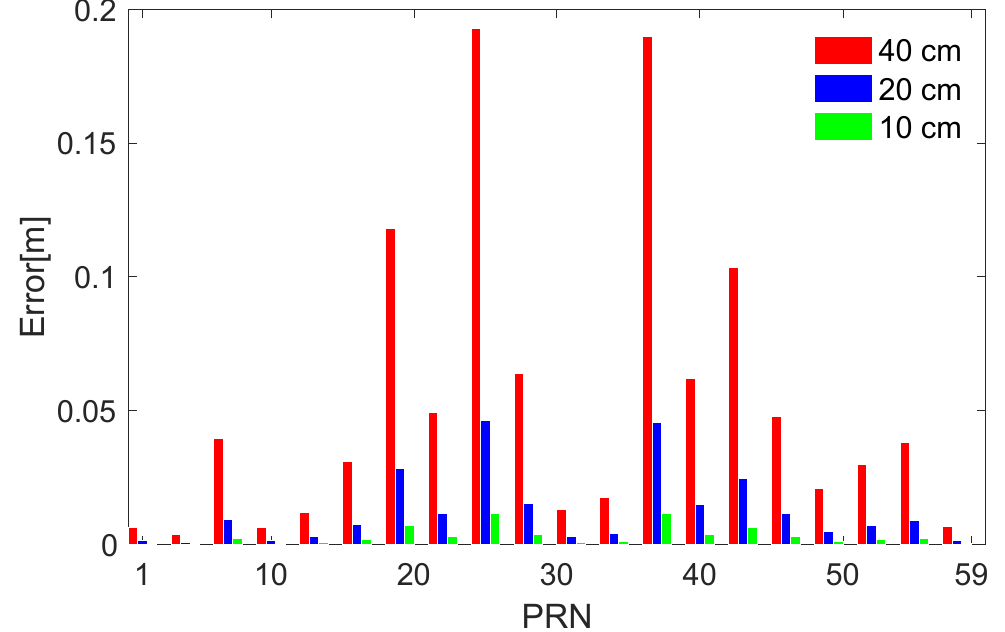
Figure 4. 60-LEO constellation orbital errors in the along-track direction under different ranging accuracies.